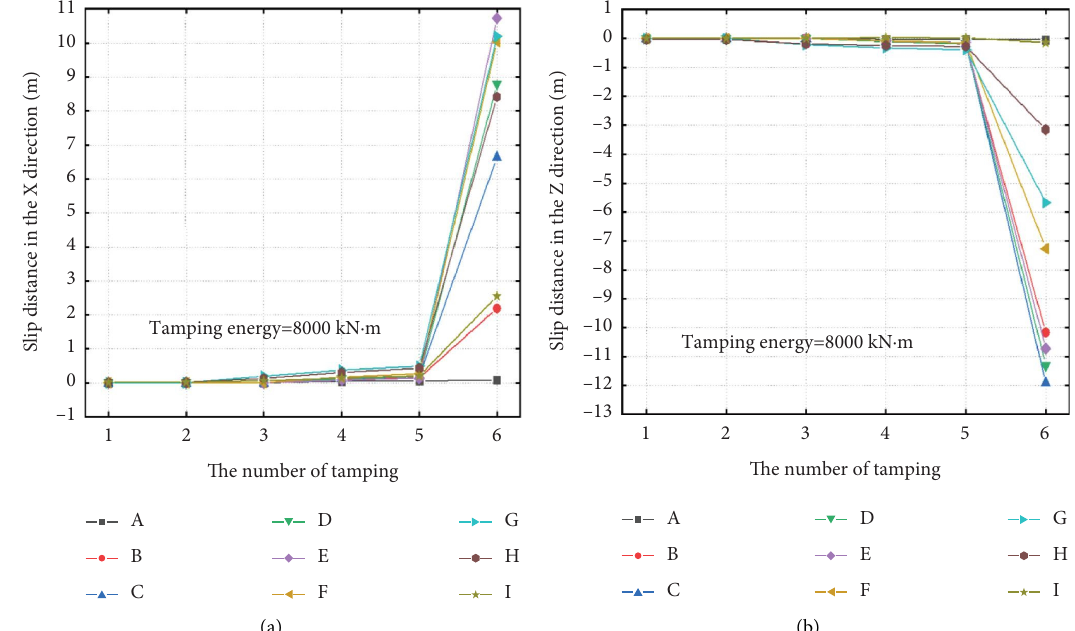
Figure 13: Horizontal and vertical displacements of soil at diferent positions under the action of 8000kN m. (a) Horizontal displacement and (b) vertical